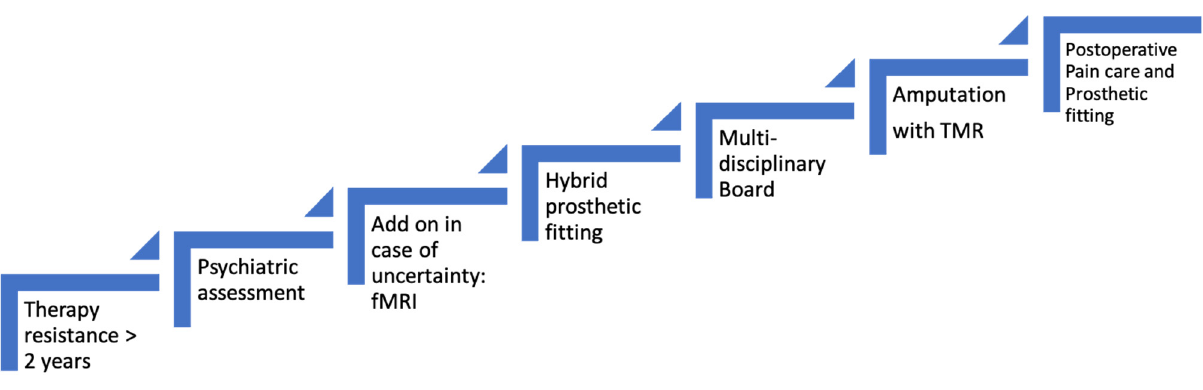
Figure 1. Algorithm for indicating amputation in CRPS patients.